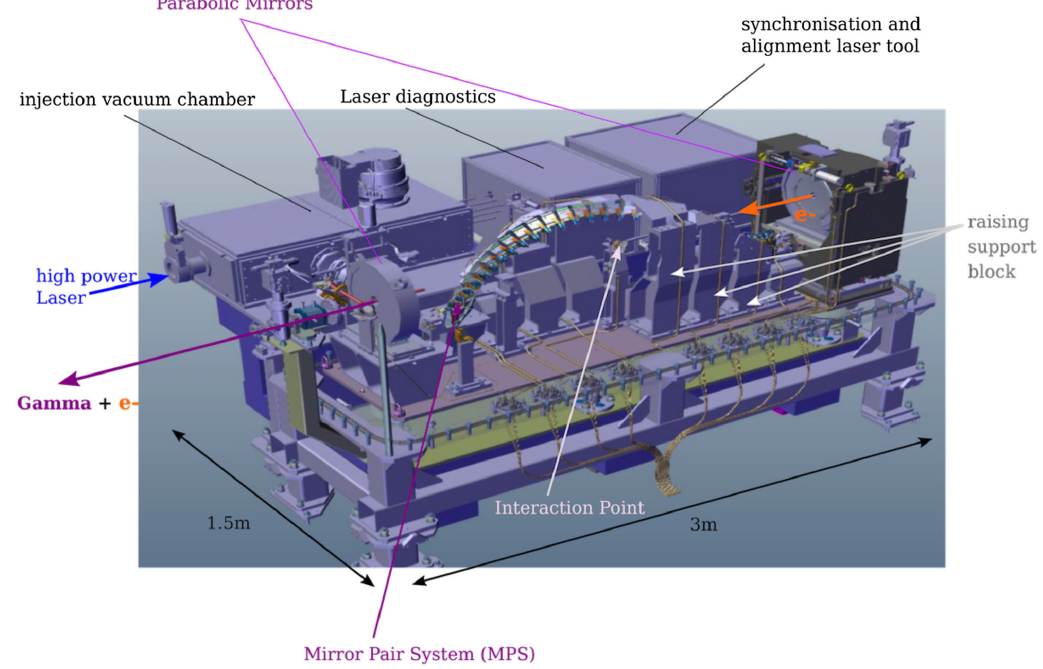
FIG. 3. 3D view of the complete interaction point module without the top cover of the LBC vacuum